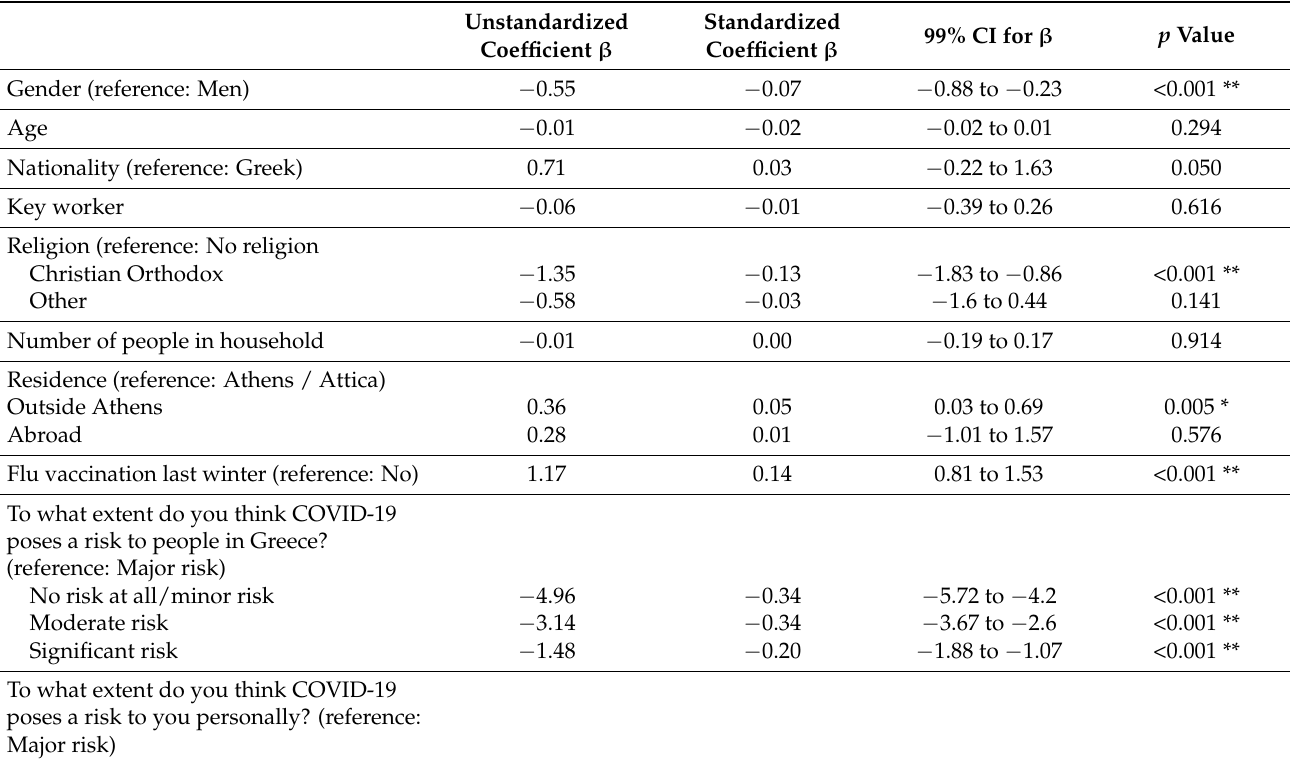
Table 5. Multiple regression analysis results with intention to get vaccinated against COVID-19 as a dependent variable, and participants’ characteristics, their perceptions of the COVID-19 pandemic, and adopting at least one behavioral change due to the COVID-19 pandemic as independent variables. Note. The model was based on 2863 cases with complete data. * p < 0.01; ** p <